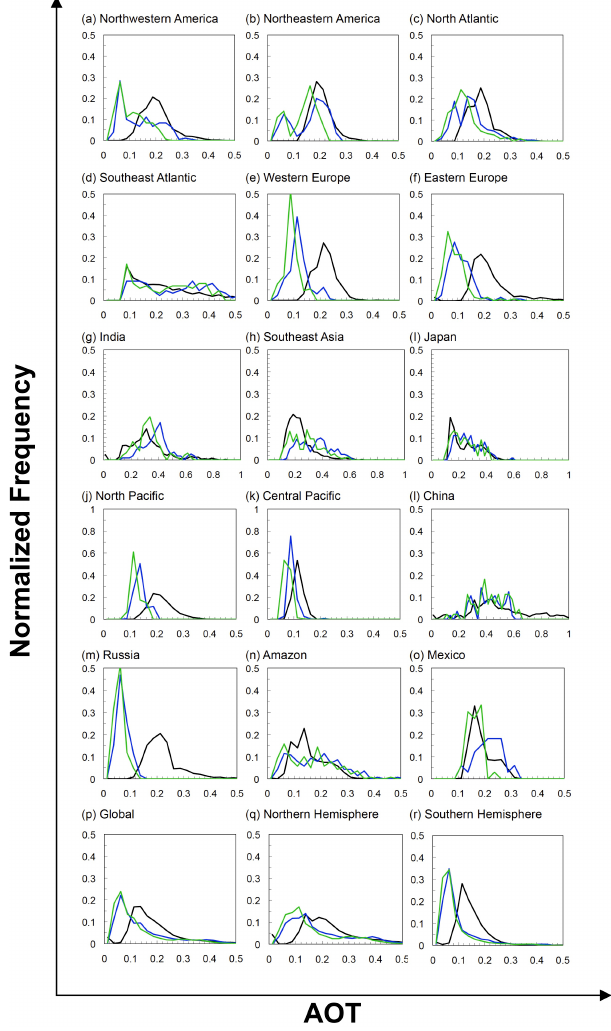
Fig. 11. Histograms of annual mean AOT calculated by two sim- ulations (NS in blue and OS in green) and in the satellite obser- vations (Terra/MODIS in black, Aqua/MODIS in light grey, and Terra/MISR in grey). The regions are West America (120 ◦